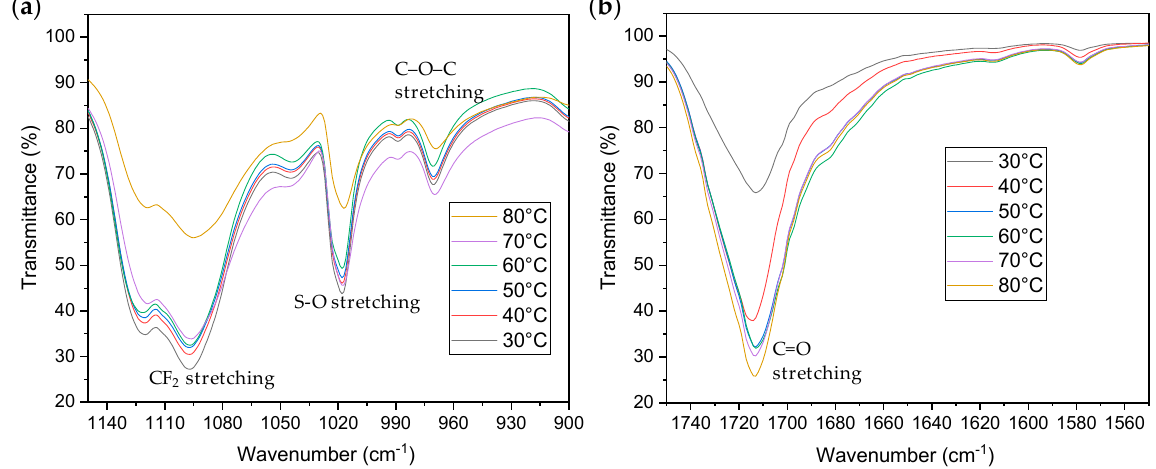
Figure 5. FTIR spectra of Nafion membranes after ex situ accelerated degradation at different temperatures: ( a ) for wavenumber ranging from 900–1150 cm − 1 ; ( b ) for wavenumber ranging from 1550–1750 cm − 1 .